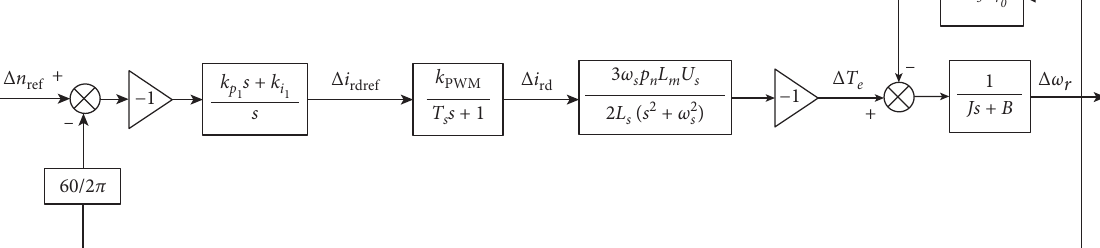
Figure 30: Linearized block diagram of the speed control closed-loop.